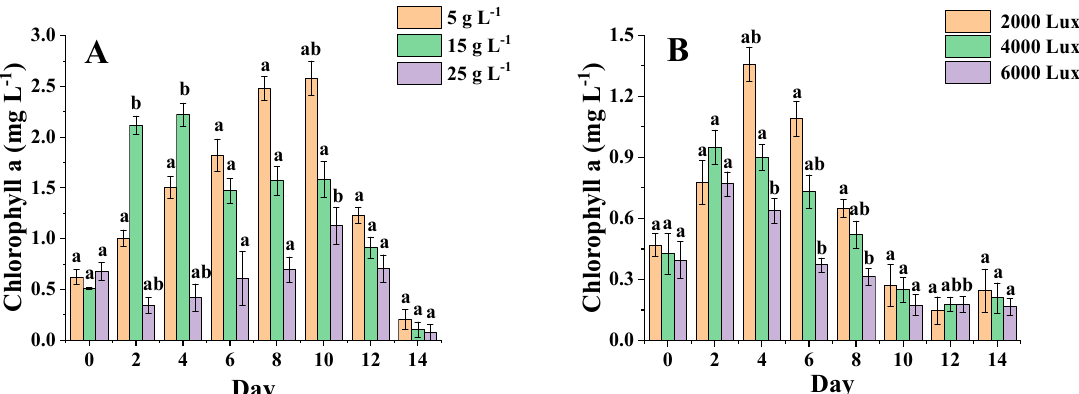
Figure 6. Chlorophyll content under different culture conditions. ( A ) represents the chlorophyll content at different NaCl concentrations; ( B ) represents the chlorophyll content under different light conditions). Different letters indicate statistical difference between groups ( p < 0.05). The results are presented as mean ± SE ( n =